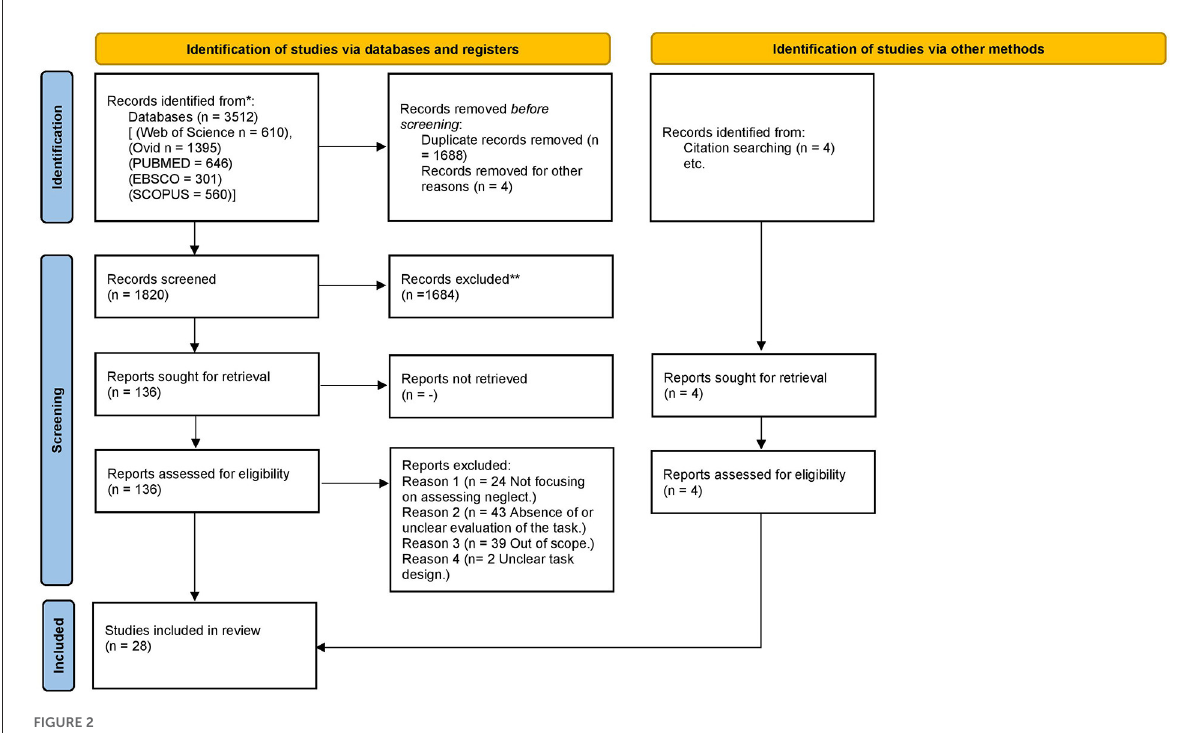
FIGURE2 PRISMA flow